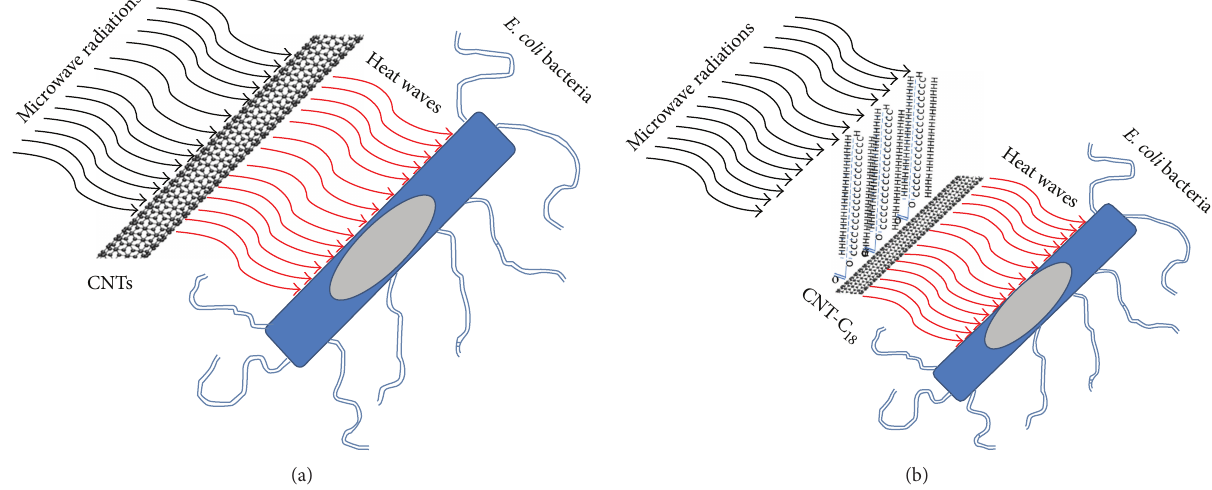
Figure 10: Schematic diagram of the thermal effect CNTs and CNT-C 18 under microwave radiation on E. coli